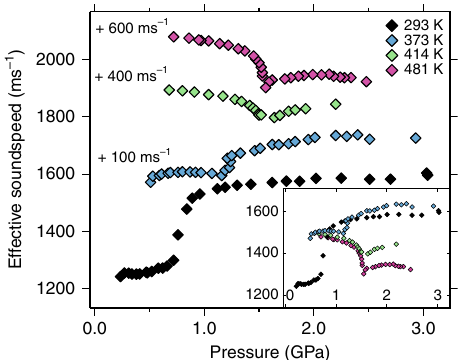
Fig. 5 Effective sound speed in cerium. The effective sound speed is a measure of the stiffness of the crystal 15 and is shown versus pressure (uncertainty < 0.05 GPa) at 293 K, 373 K, 414 K, and 481 K. Curves individually offset for clarity. Symbols are larger than the